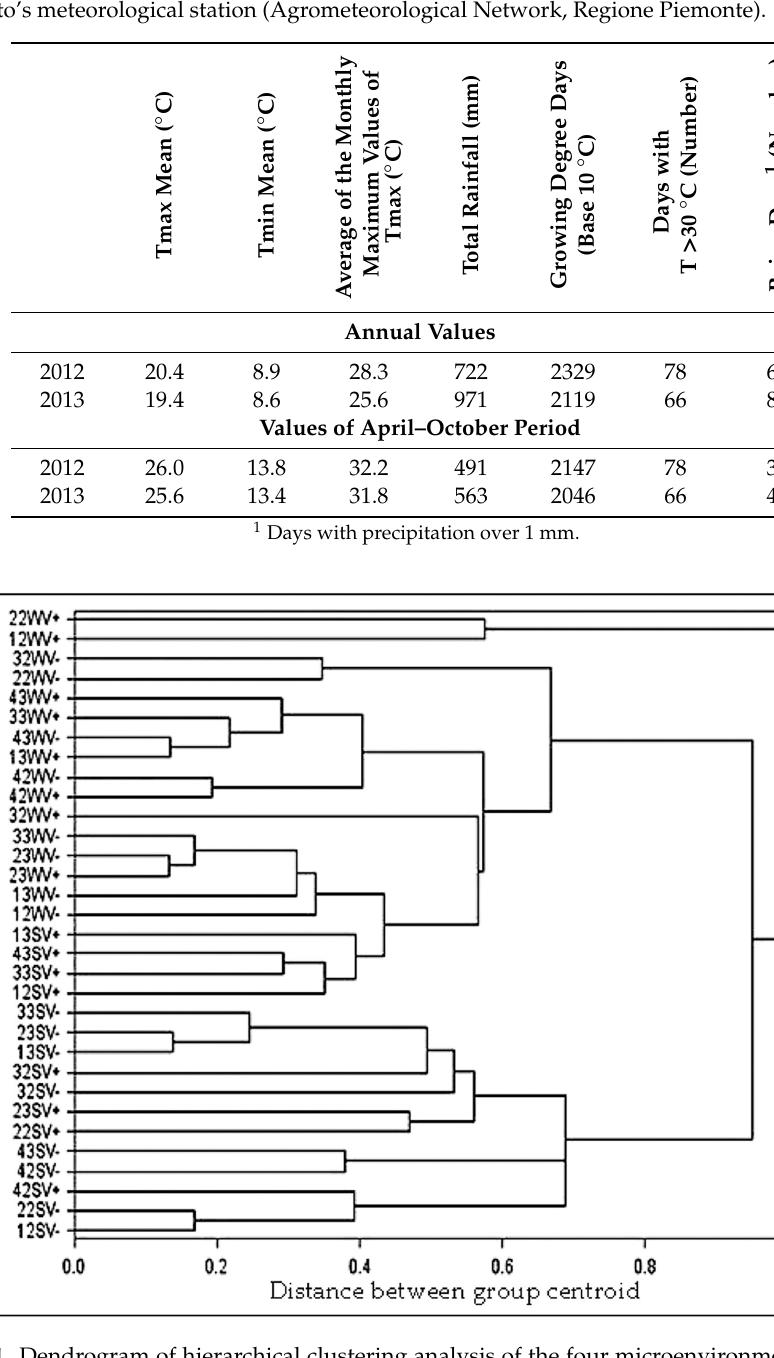
Table 2. Meteorological characterization of the two seasons (the values are calculated both for the entire year and for the grapevine vegetative period: April–October). Data were registered by Serralunga Boscareto’s meteorological station (Agrometeorological Network, Regione Piemonte).